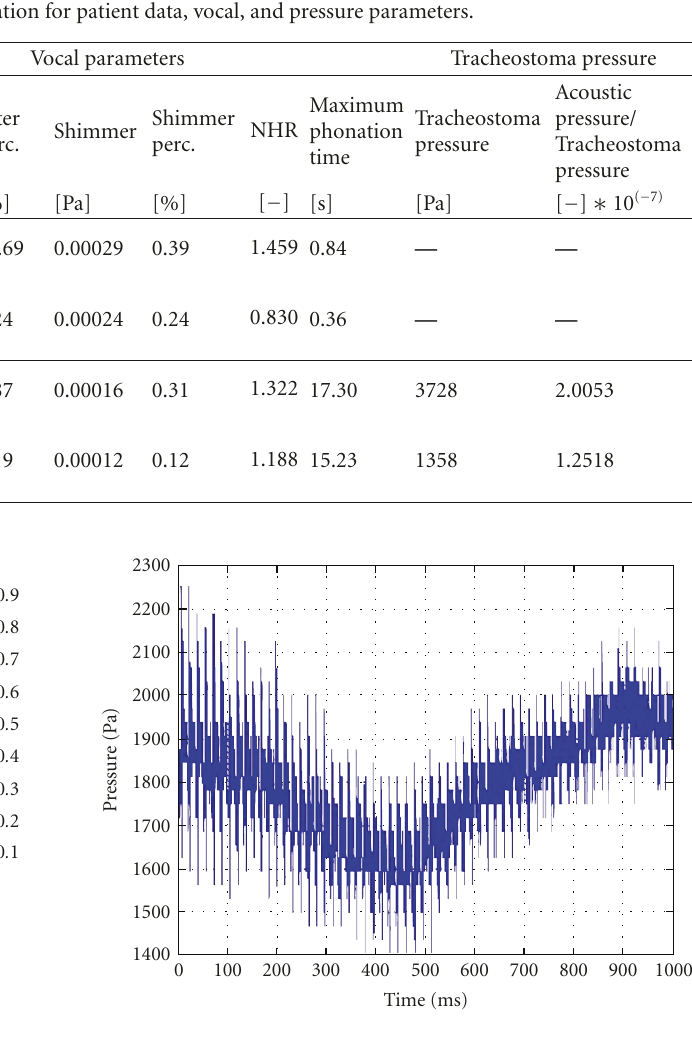
Figure 8: Pressure signal versus time (TEP3).